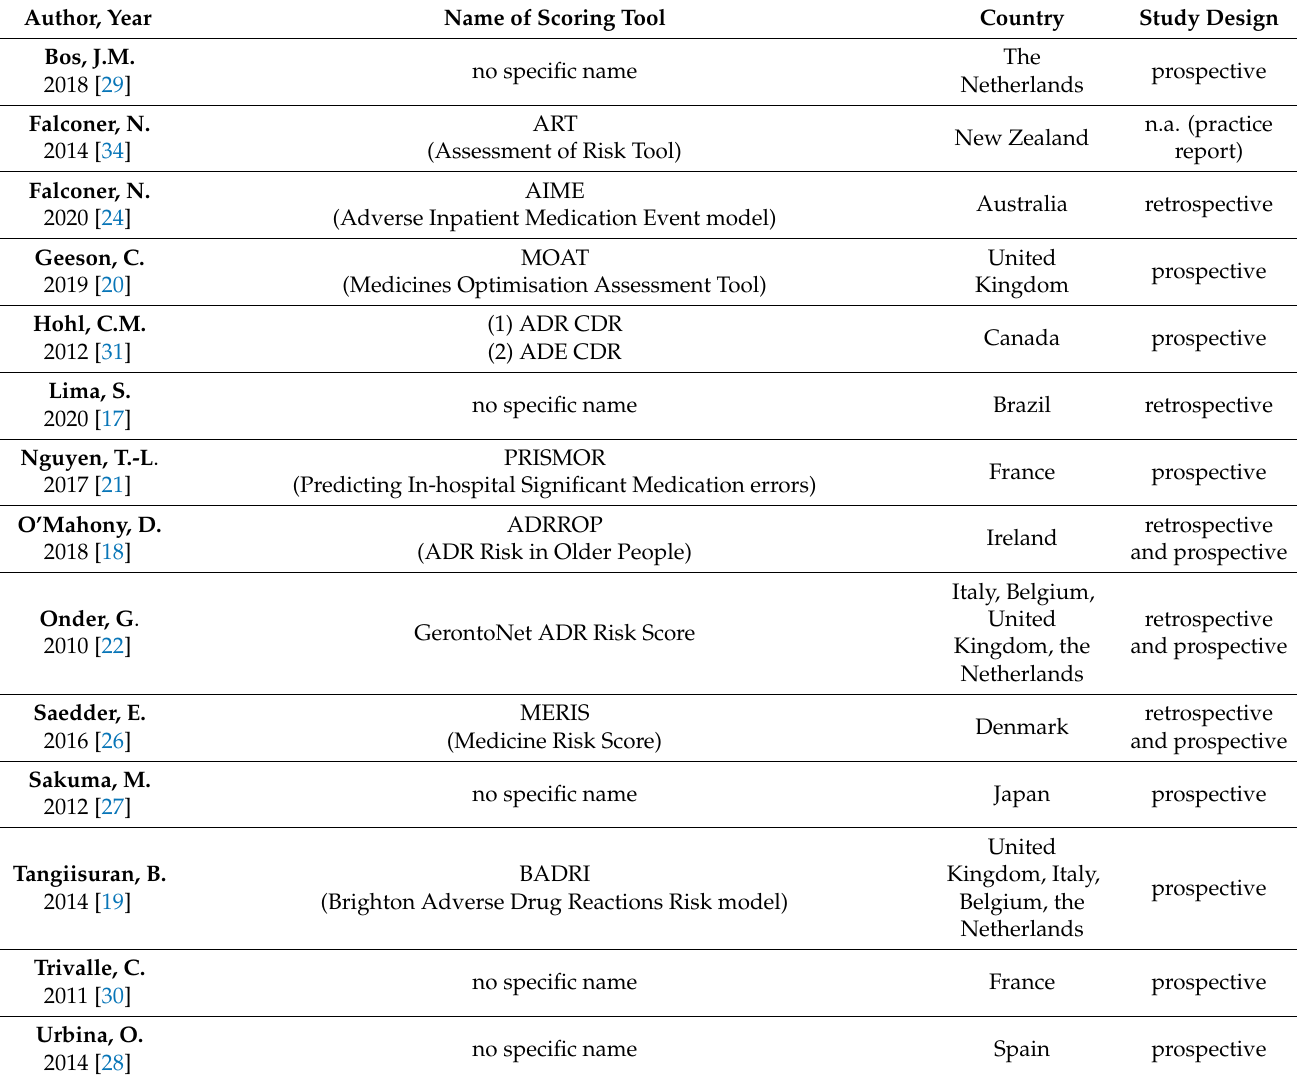
Table 1. Characteristics of the 14 included